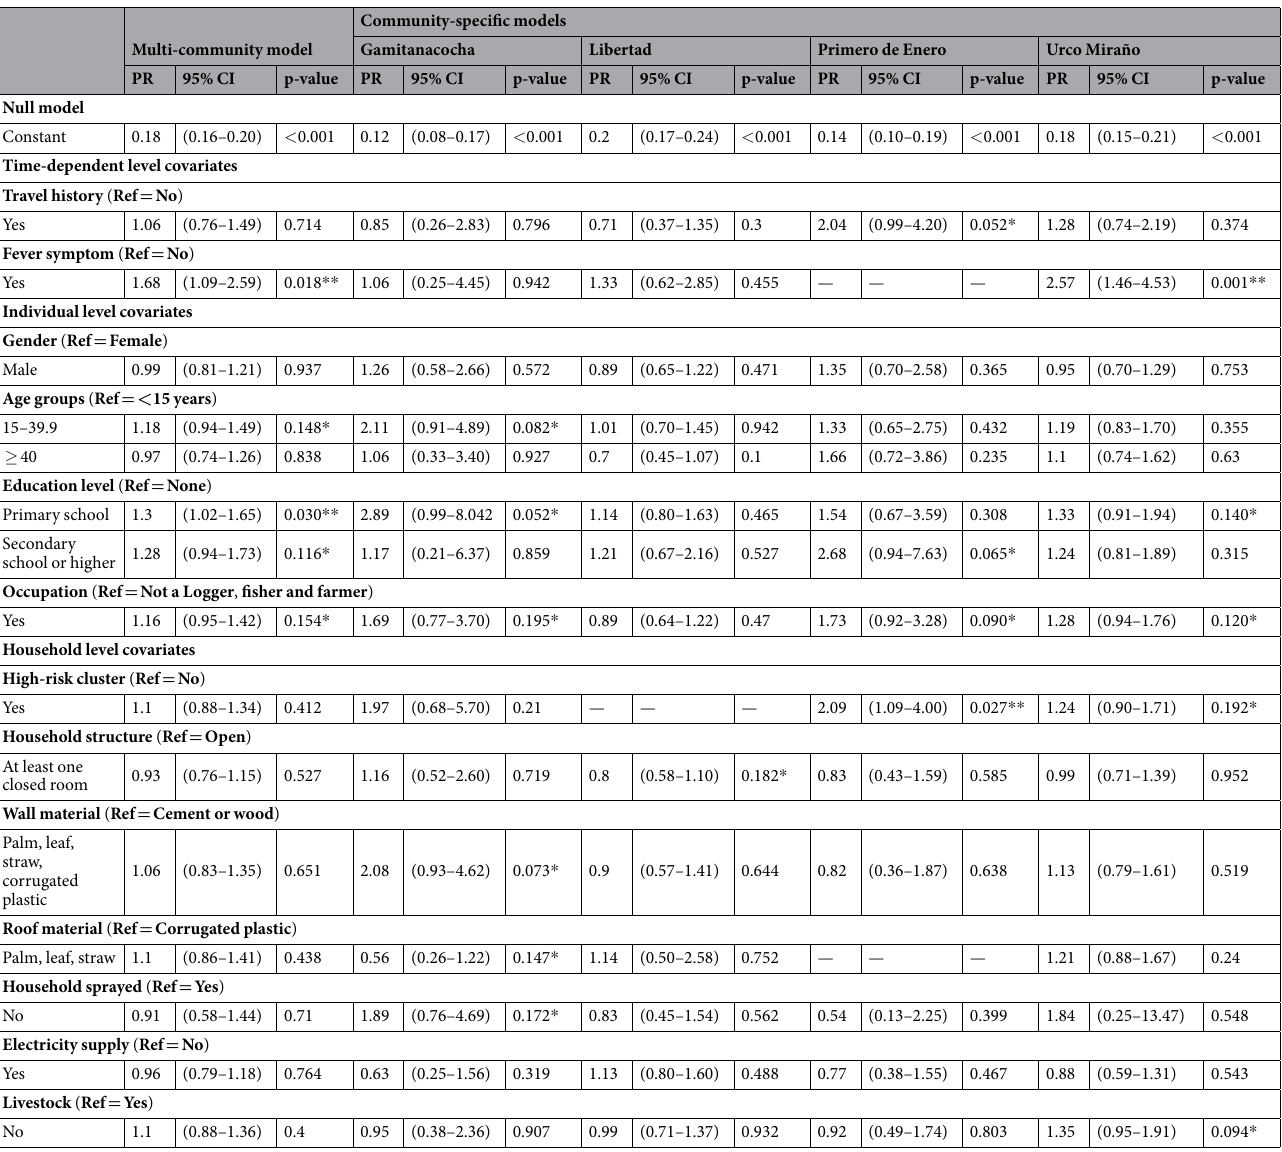
Table 3. Fixed effects of multi-community and community-specific bivariates models for P . vivax